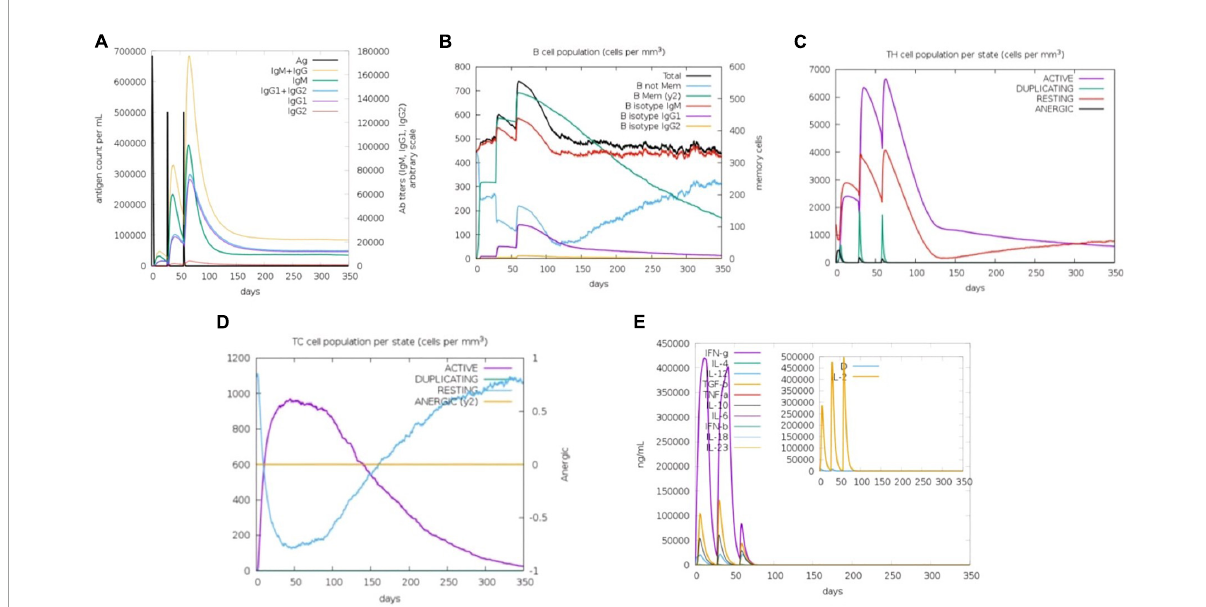
FIGURE5 Immune simulation of vaccine construct (V2) in three injections by C-immsim server. (A) Primary response by antigen exposure, (B) B-cells immune reaction, (C) helper T-cells immune reaction, (D) cytotoxic T-cells immune reaction, (E) Simpson index D graph representing cytokines and Interleukin